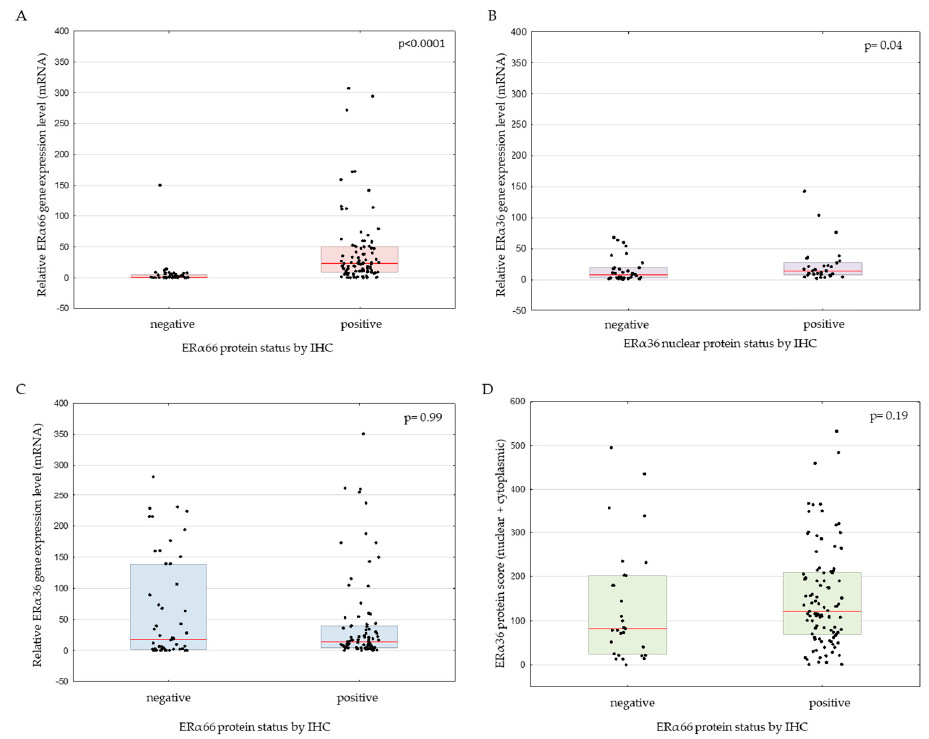
Figure 5. ER α 66 relative expression according to ER α 66 immunohistochemical (IHC) protein status ( A ), ER α 3 6 relative expression according to ER α 36 nuclear protein ( B ), ER α 3 6 expression according to ER α 66 protein status ( C ), and ER α 36 protein immunohistochemical score according to ER α 66 protein status ( D